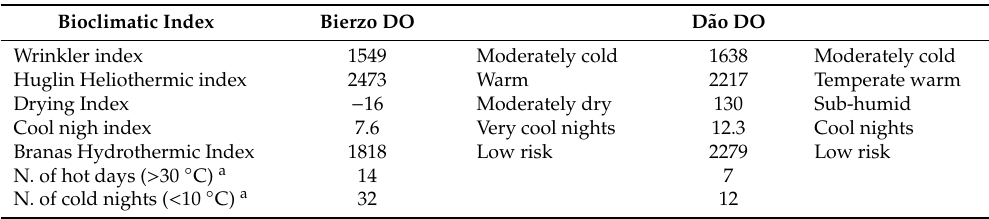
Table 3. Bioclimatic index of Bierzo D.O. and D ã o D.O. for 2015 and classes of the viticultural climate of the grape-growing